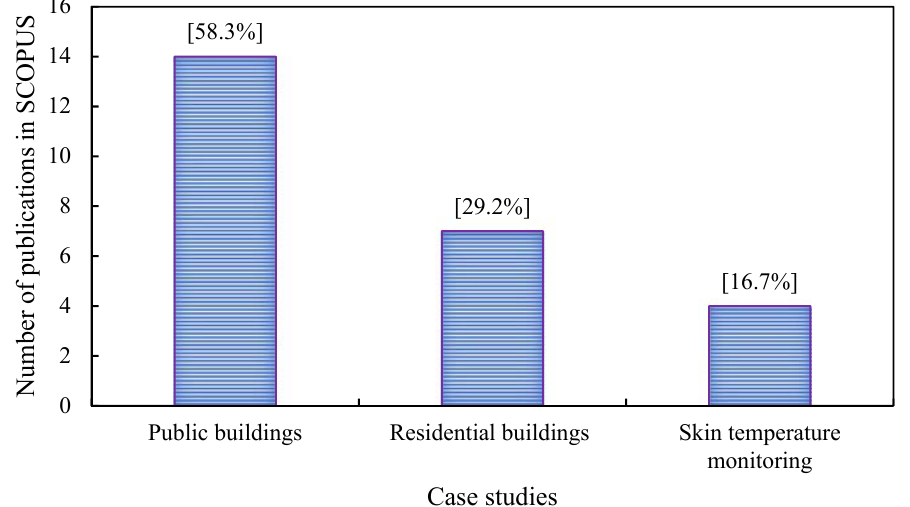
Figure 7. Three groups of case studies in the SCOPUS database for application of low-cost sensors on thermal comfort monitoring and HVAC in the building sector. Group 1: focusing on public buildings, group 2: focusing on residential buildings, and group 3: focusing on measuring skin temperature of people.